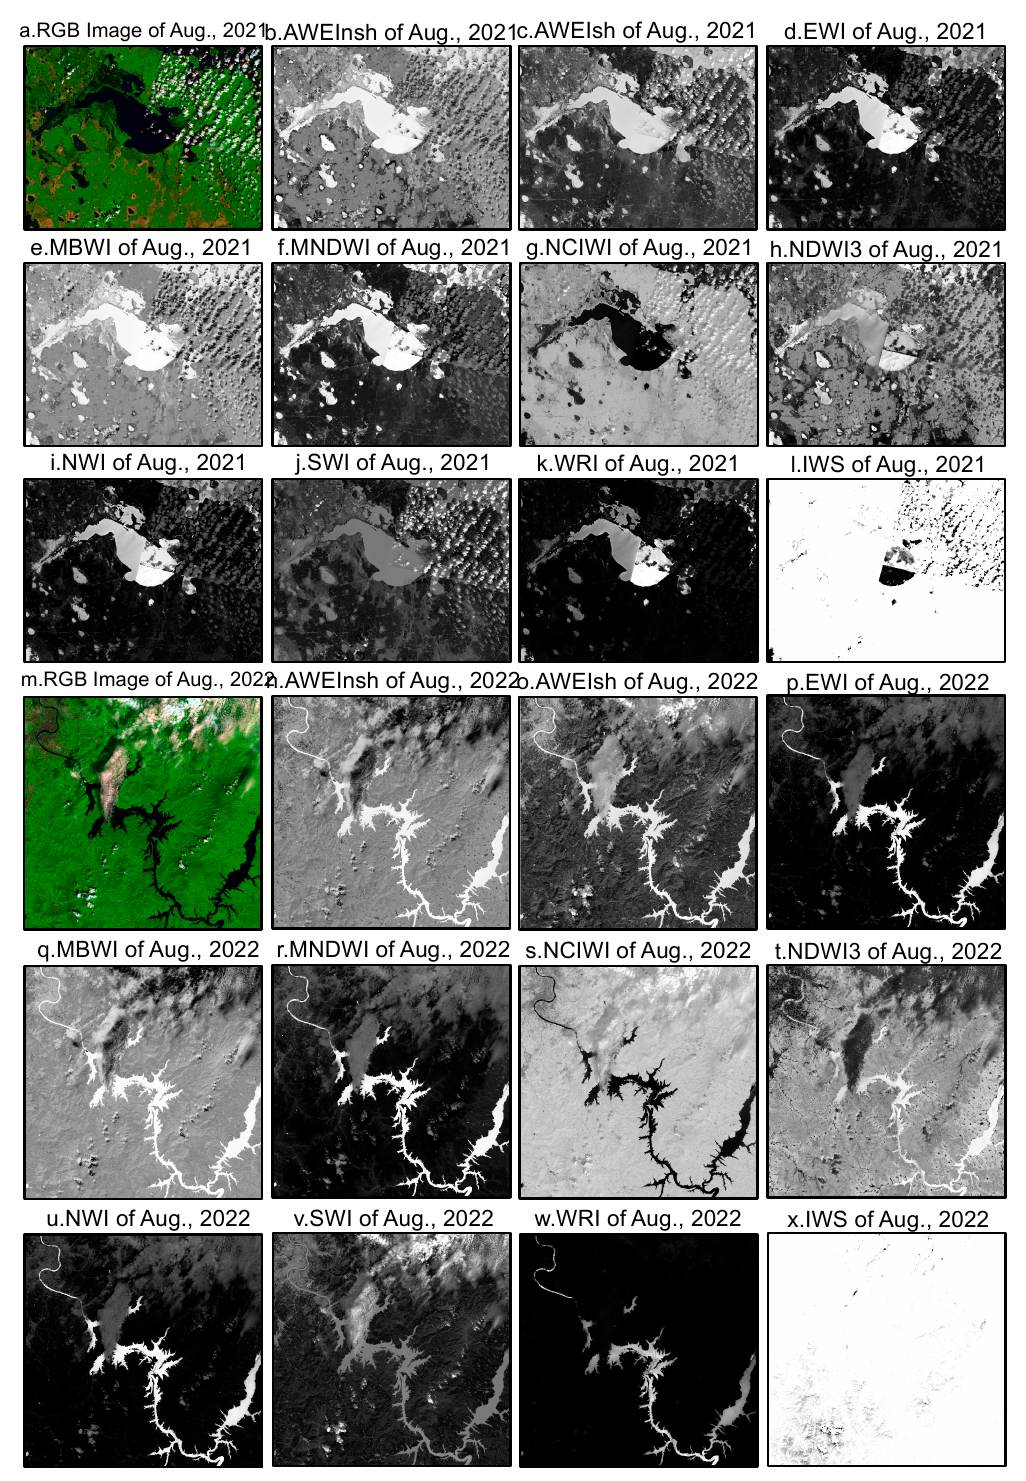
Figure 3. The multispectral image and the grayscale images of water indices of August 2021.